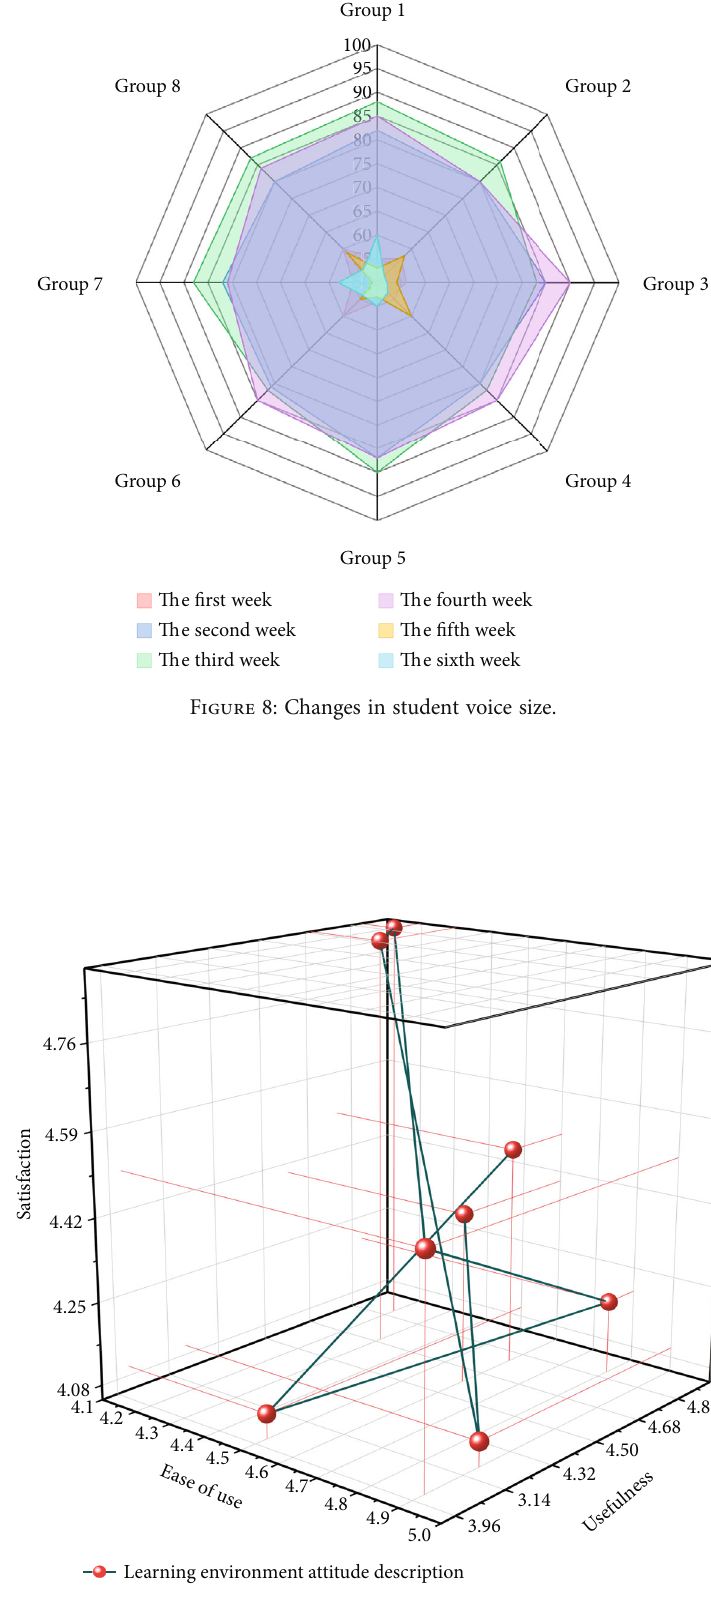
Figure 9: Description of students ’ attitude towards learning environment for AR game teaching.